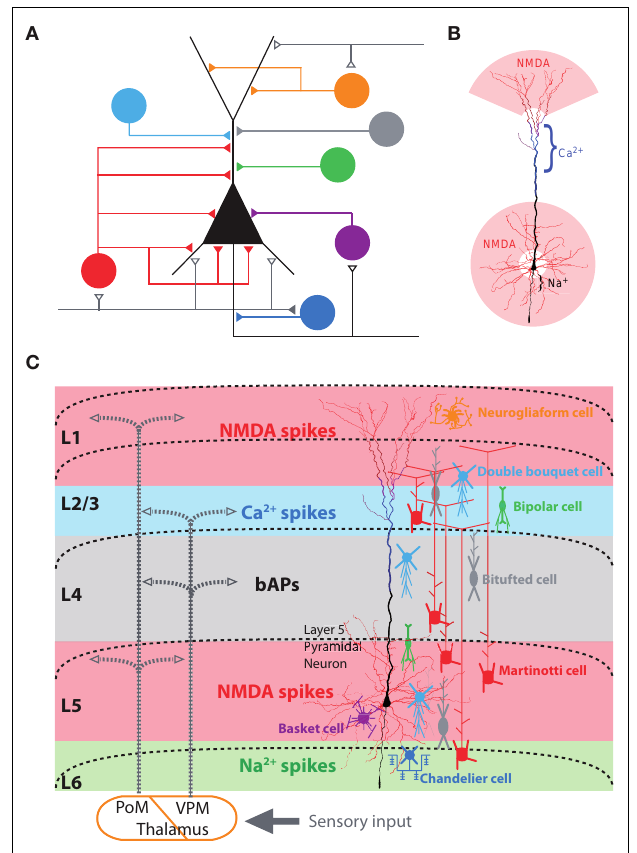
FIGURE 1 | Sources of dendritic inhibition on neocortical pyramidal neurons. (A) Various inhibitory cell types and their axonal target regions on the pyramidal neuron’s dendritic tree. Adapted from (Benardo andWong, 1995). (B) Electrogenic regions of the layer 5 neocortical pyramidal neurons. The dendritic regions which generate NMDA spike (red), Ca 2 + spikes (blue), and Na 2 + spikes (black) are color-coded (Larkum et al., 2009). (C) Schematic of the cortical network showing the relationship between long-range excitatory synaptic input, axonal projections of inhibitory neurons, and the layer 5 pyramidal neuron with its local electrogenic properties. Interneuron subclasses known to target dendrites and axons are schematically illustrated according to their layer specific distribution (colors corresponding to A ). Seen from this perspective, axon terminations in different cortical lamina are likely to have specific influences on different spiking mechanisms within the pyramidal neurons [NMDA spike (red), Ca 2 + spikes (blue), backpropagating APs (black), and axonal Na 2 + spikes